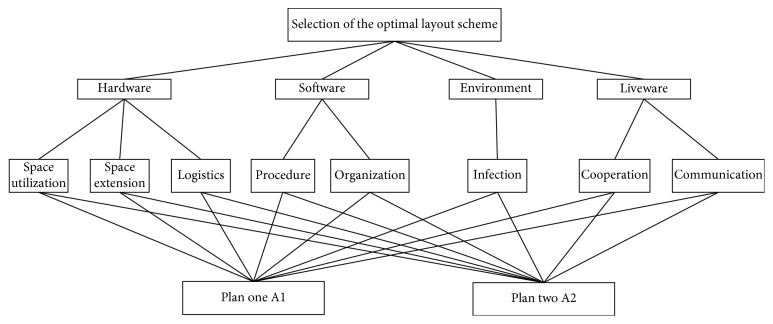
Decision hierarchy.